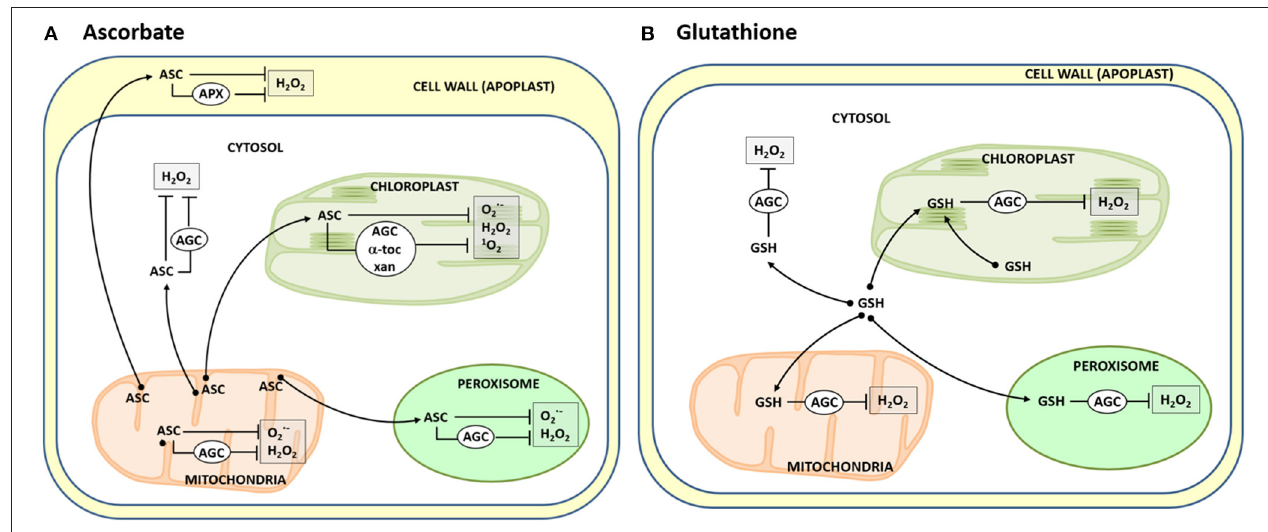
FIGURE 1 | Dynamics of ascorbate (A) and glutathione (B) in plant cells. Ascorbate (ASC) generated in the mitochondrial membranes [see Rodríguez-Ruiz et al. (2017) and Martí et al.] is driven to the different cell loci where it is used to neutralize diverse ROS [superoxide radicals (O ·− 2 ), hydrogen peroxide (H 2 O 2 ), and singlet oxygen ( 1 O 2 )] generated in the organelles. This occurs directly or indirectly through either the participation of the ascorbate peroxidase (APX) and the enzymes of the ascorbate-glutathione cycle (AGC), regenerating α -tocopherol ( α -toc), or the xanthophylls’ cycle (xan). Likewise, glutathione (GSH), synthesized in the cytosol and chloroplasts, is basically used as well in different cell compartments to indirectly scavenge H 2 O 2 through the